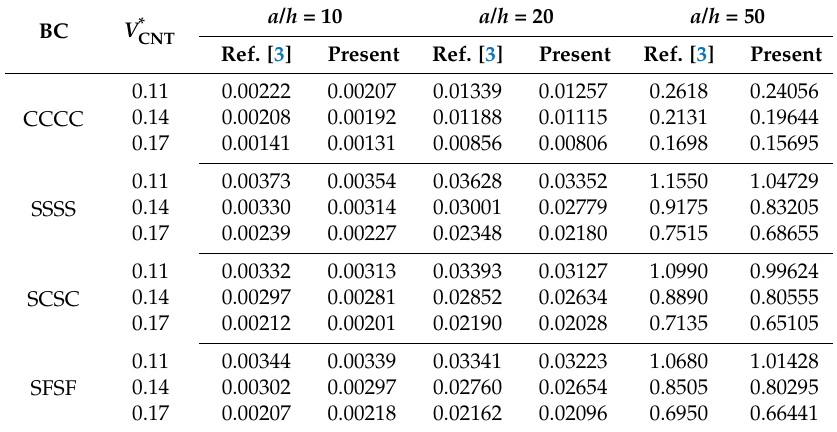
Table 6. Maximum transverse deflection w for a UD CNT-reinforced square plate with a/h